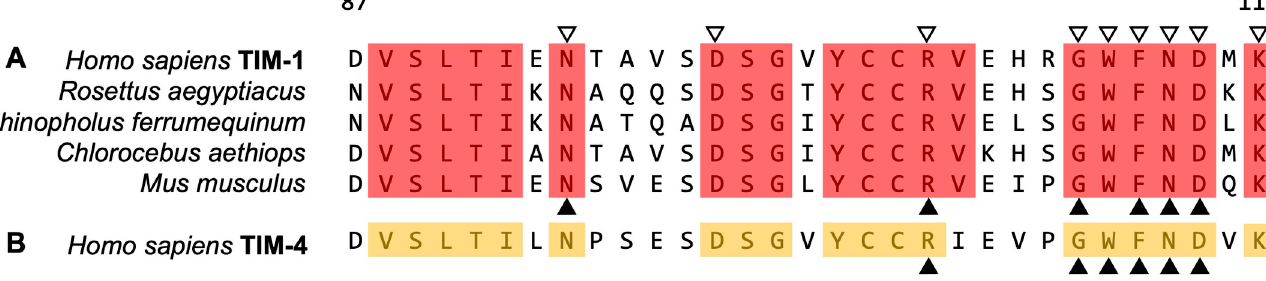
PLOS Pathogens| https://doi.org/10.1371/journal.ppat.1009899 September 23,